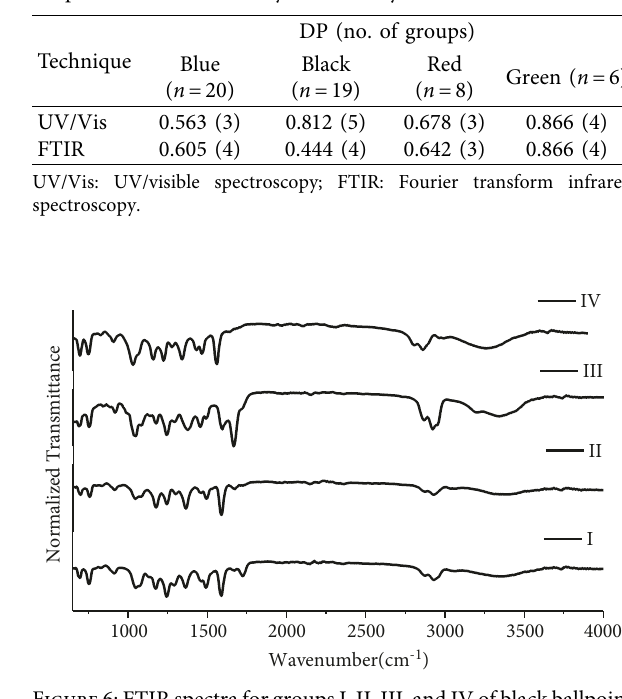
Figure 6: FTIR spectra for groups I, II, III, and IV of black ballpoint pen